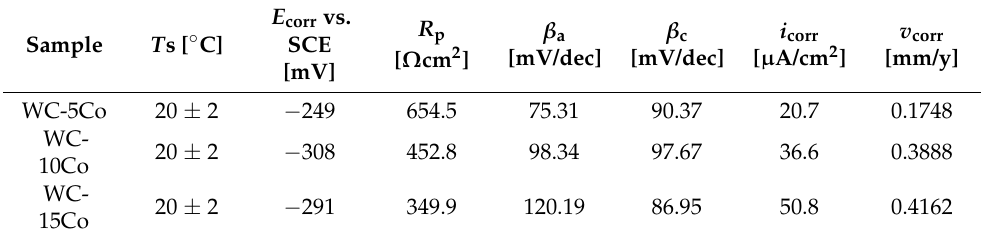
Table 4. Electrochemical impedance spectroscopy EIS technique results.